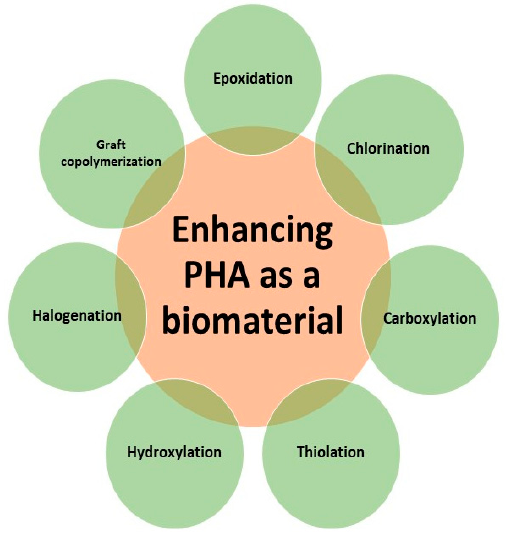
Figure 3. Different methods employed to increase the capability of PHA as a biomaterial. These methods modify the polymer PHA and help in crosslinking, blending, modifying, and allowing them to develop as sound nanocomposites for various applications.